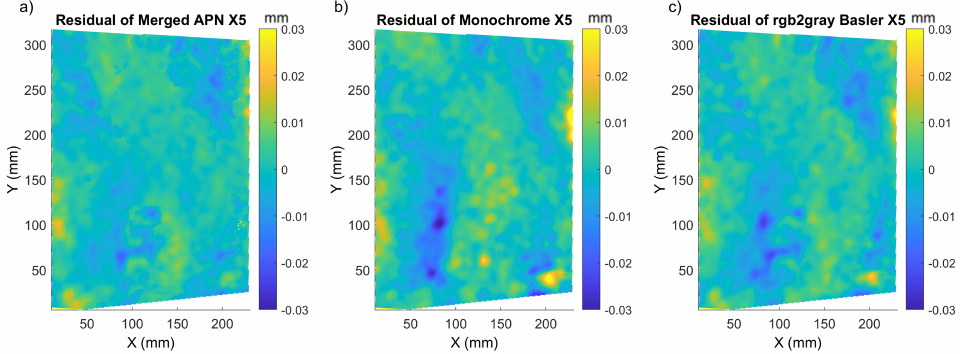
Figure 10. X5 residual displacement maps for Flower corresponding to: ( a ) merged APN, ( b ) Monochrome and ( c ) Basler converted to